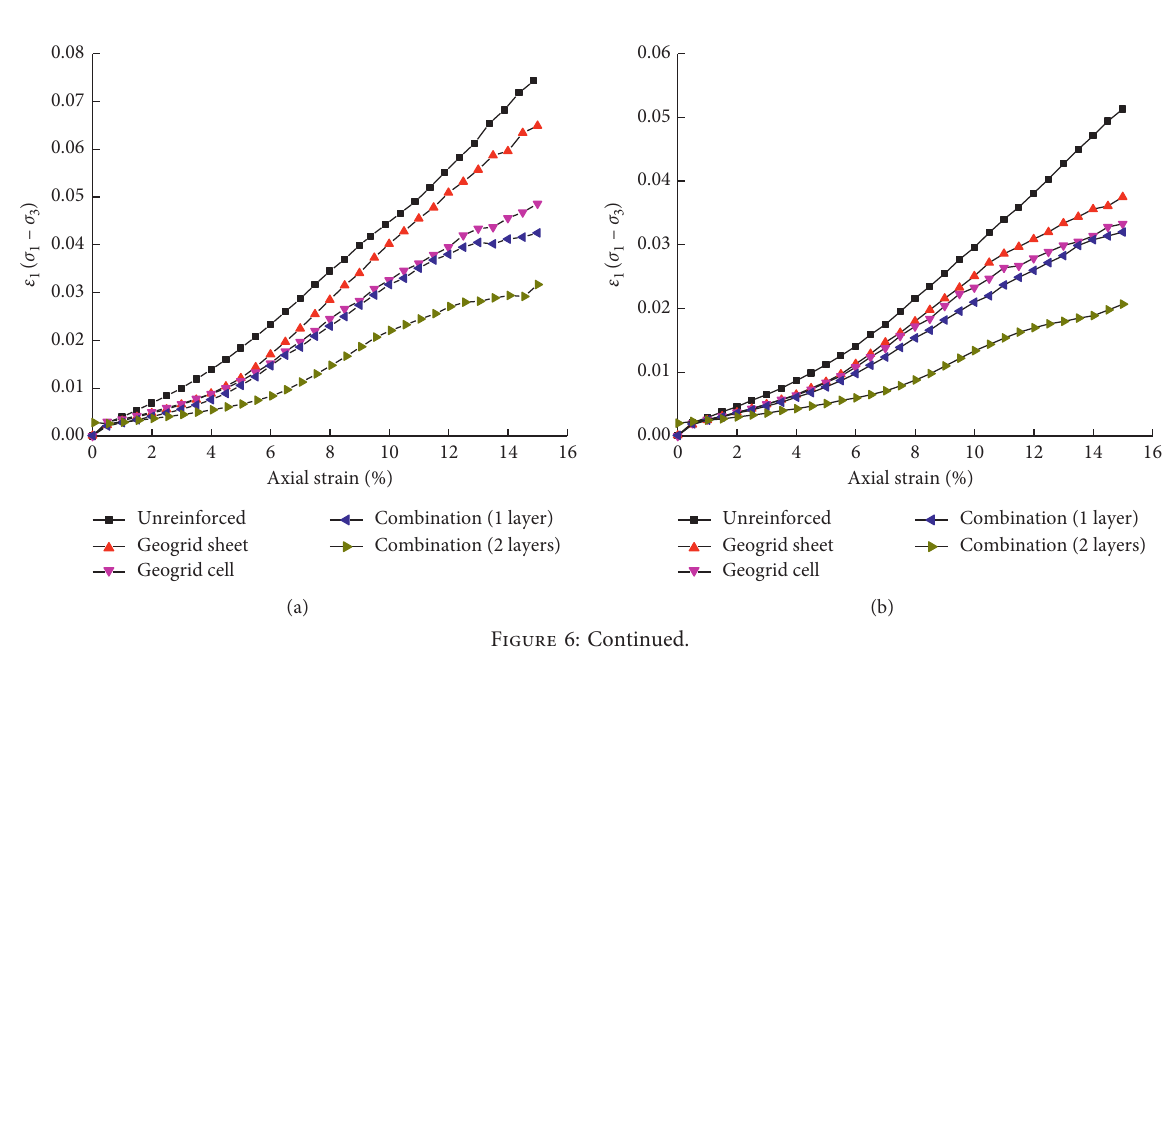
� 50kPa, (b) σ � 75kPa, and (c) σ � 3 3 3